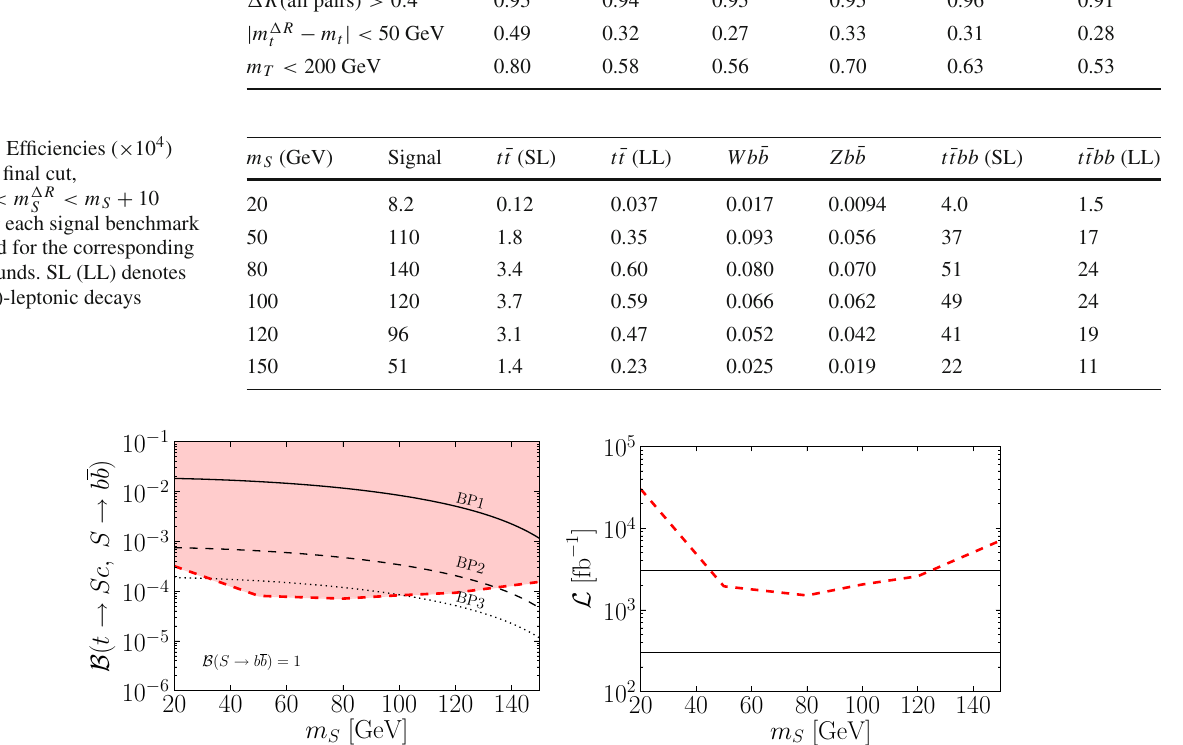
Fig. 2 (Left) Branching ratios that can be tested in the bb channel. Superimposed are the theoretical expectations in the three BPs. (Right) Luminosity required to test B ( t → Sc , S → bb ) = 10 − 4 . Superimposed are L = 300 fb − 1 and 3000 fb −